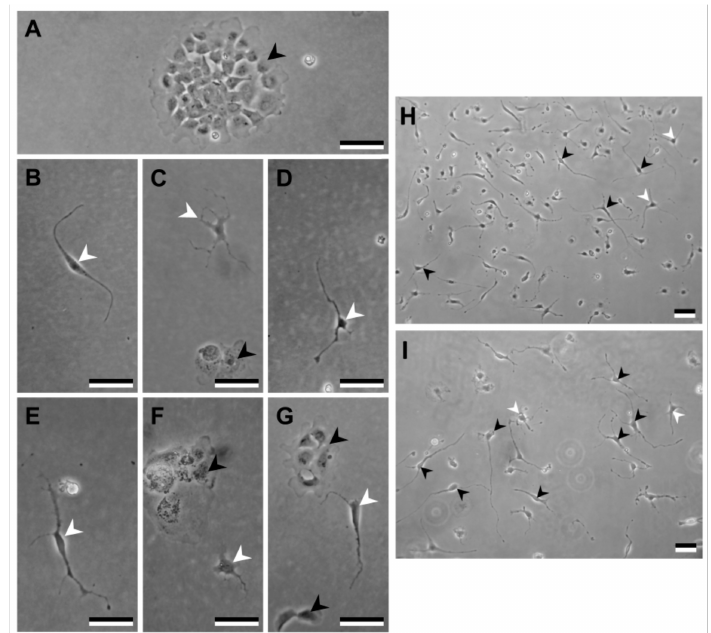
Figure2. Spontaneousdi ff erentiationofzebrafishblastemacellsafter5daysinculture. ( A )Homogenous progenitor blastema cells showing polygonal cells with prominent nuclei and sparse cytoplasm. ( B – G ) Di ff erentiated cells exhibiting a spindle-like ( B ), an oligodendritic-like ( C ), and a neuron-like ( D – G ) phenotype. Black and white arrowheads show progenitor blastema cells and di ff erentiated cells, respectively. ( H , I ) Phase-contrast micrographs of zebrafish blastema cells exposed to 0.5 µ m all- trans retinoic acid at day 7. Neuron-like (black arrowheads) and oligodendritic-like (white arrowheads) cells at 7 days of treatment. Scale bar is 50 µ m in ( A – G ) and ( I ), and 100 µ m in ( H